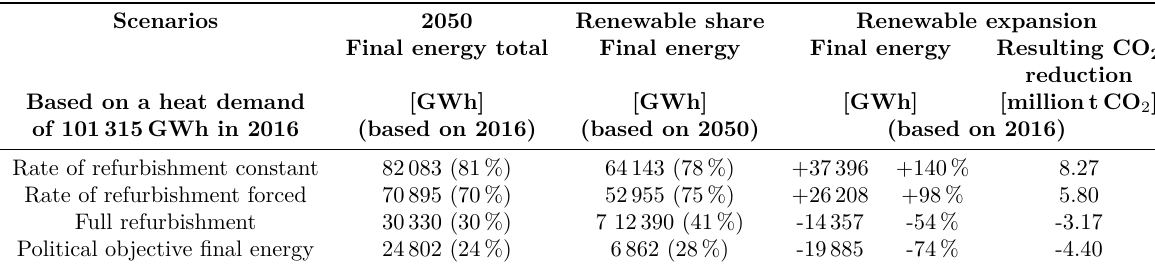
Table 2. Requirements to achieve CO